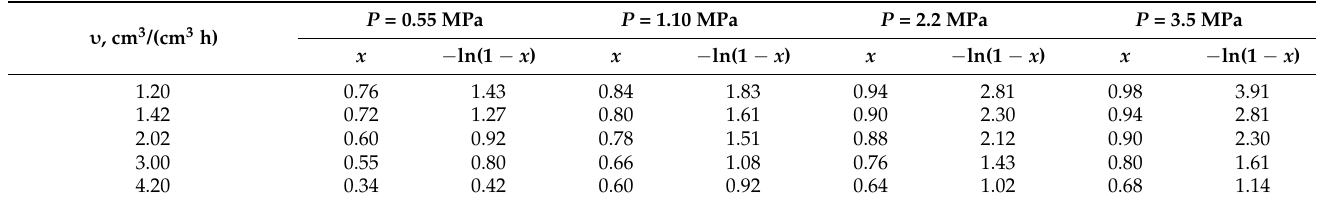
Table 2. Dependence of the sulfur compounds conversion, x, on the pressure P of the reaction mixture in the reactor ( υ —volumetric flow rate of the diesel fraction).